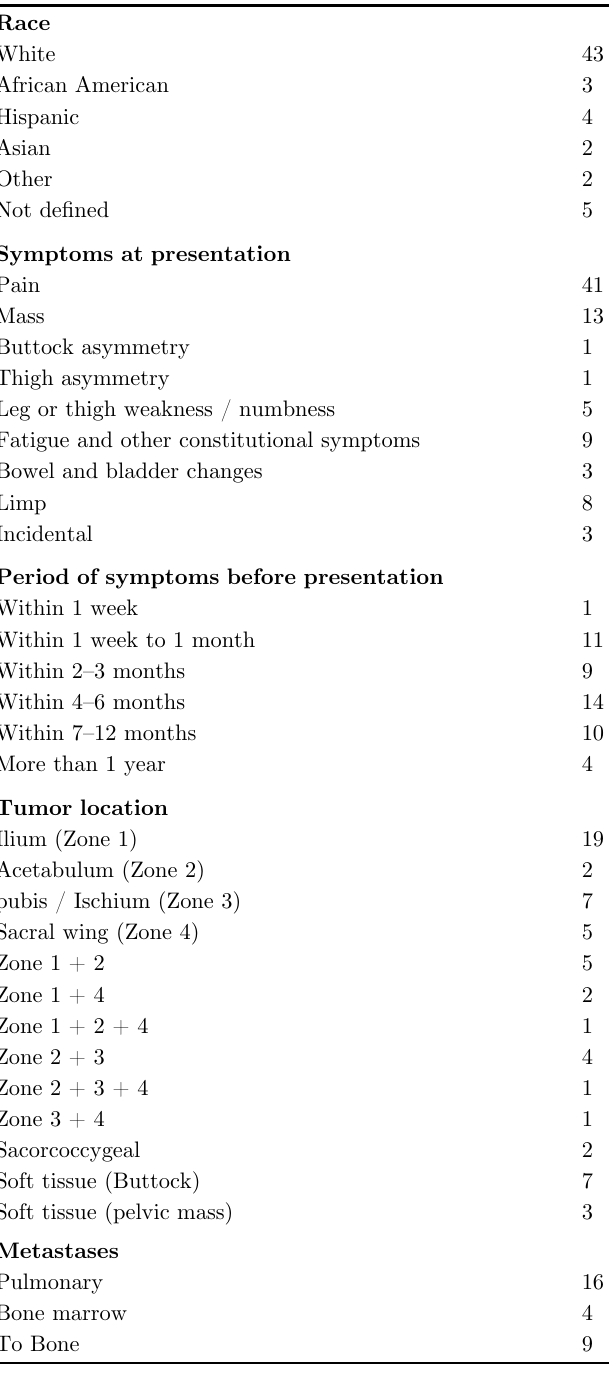
Table 1. List of symptoms at